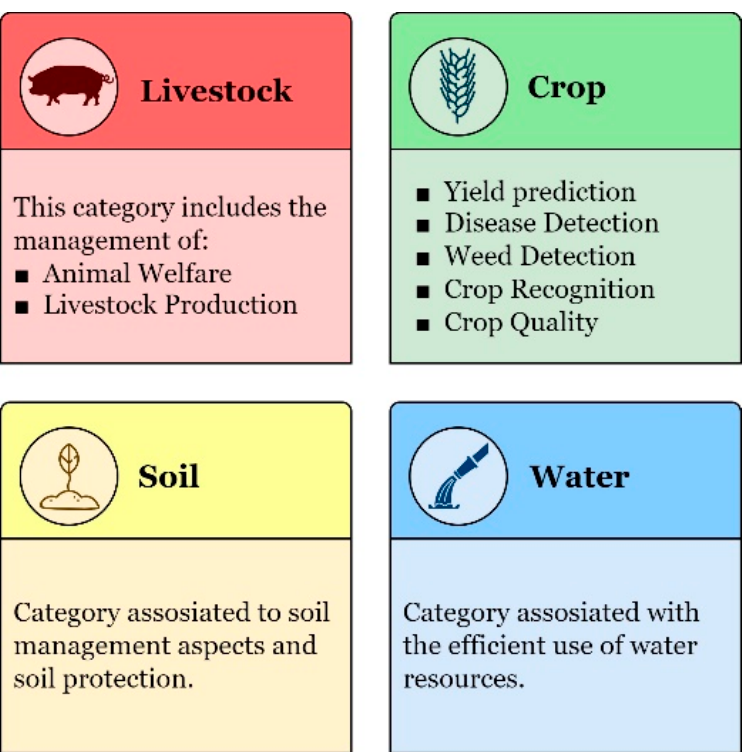
Figure 2. Use of ML in agriculture, modified from the reference [16].